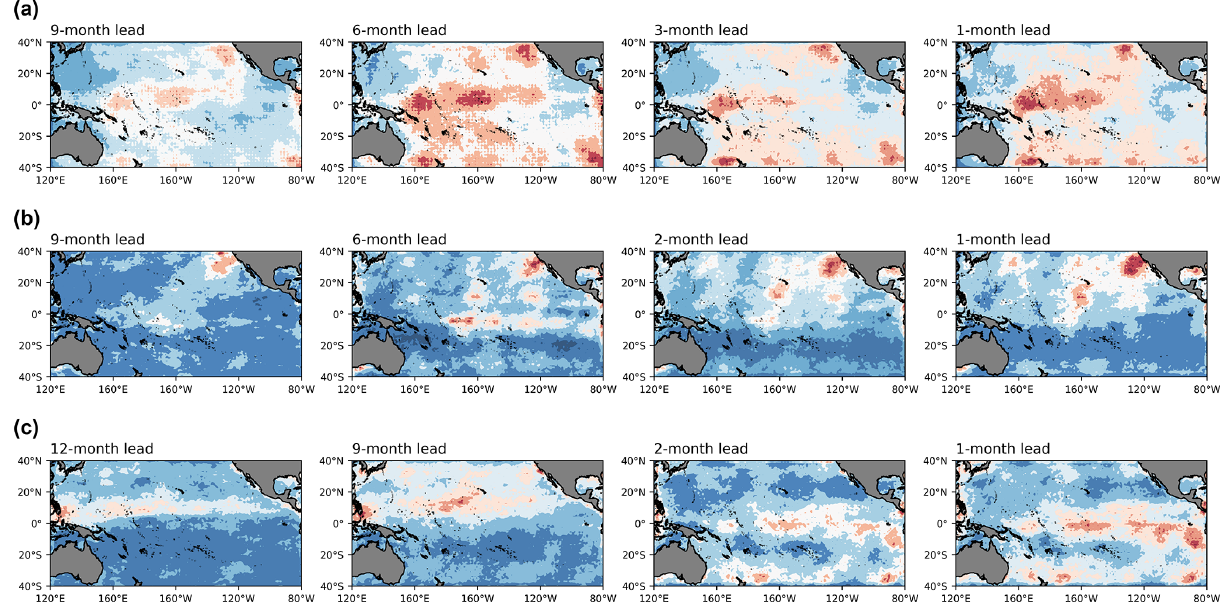
Figure 15. The composite evolution maps of initial perturbations in heat content before (a) EP-type El Niños, (b) CP-type El Niños and (c) La Niñas from 12-month lead to 1-month lead.